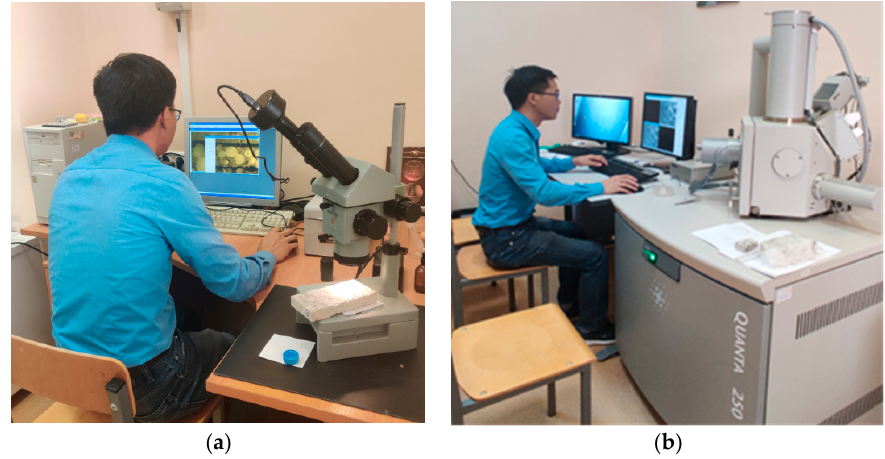
Figure 3. The experiments of the formation and geometric characteristics of the contact zone between layers with the stereoscopic microscope MBS10 ( a ) and Quanta 250 ( b ).